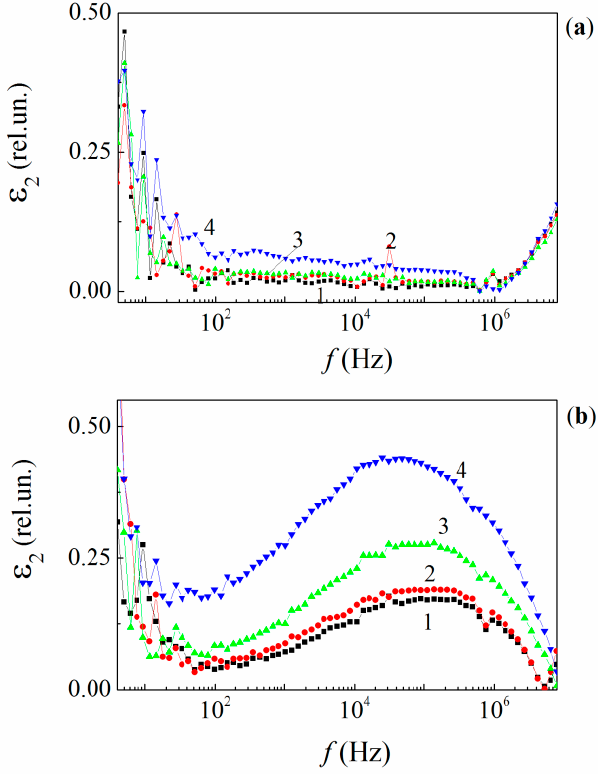
Figure 12. Frequency dependences of the relative dielectric loss factor for the neat epoxy (1) and MLG composites with 1% (2), 2% (3), and 5% (4) MLGs at temperatures of 95 К ( а ) and 300 K ( b ).